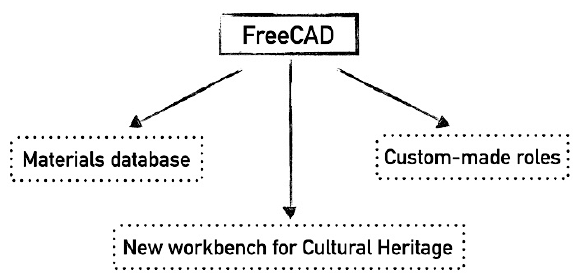
Figure 1. Possible customizations under FreeCAD for the Cultural Heritage